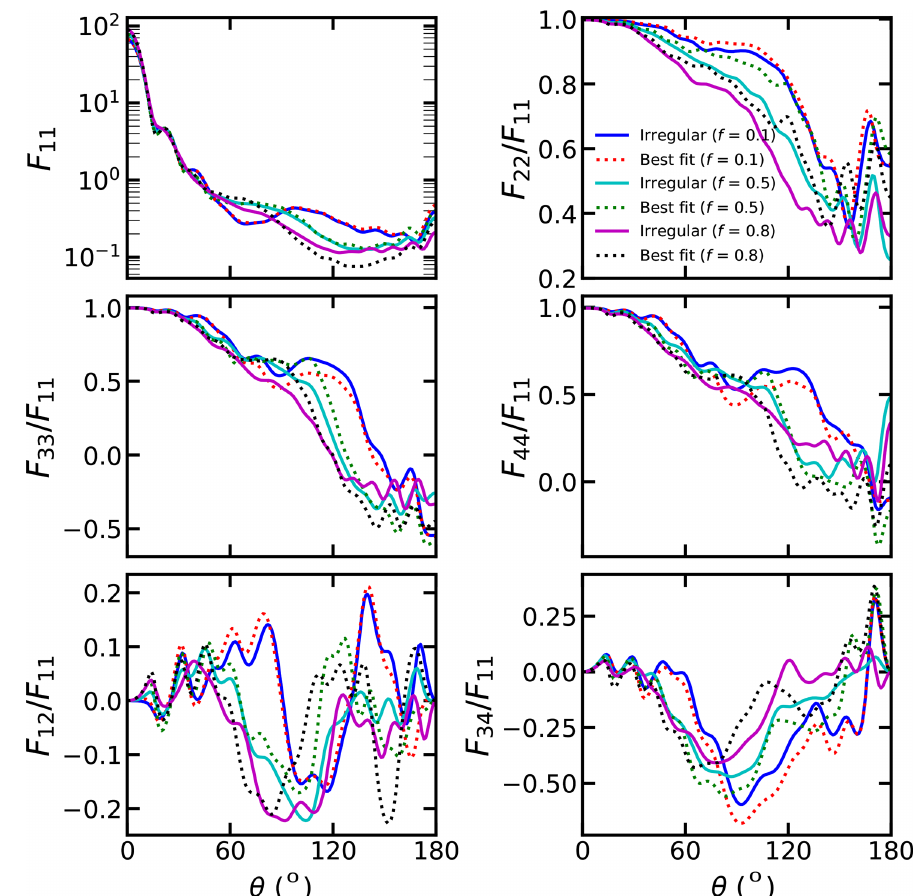
Figure 4. Similar to Fig. 3 but for d p = 2 .